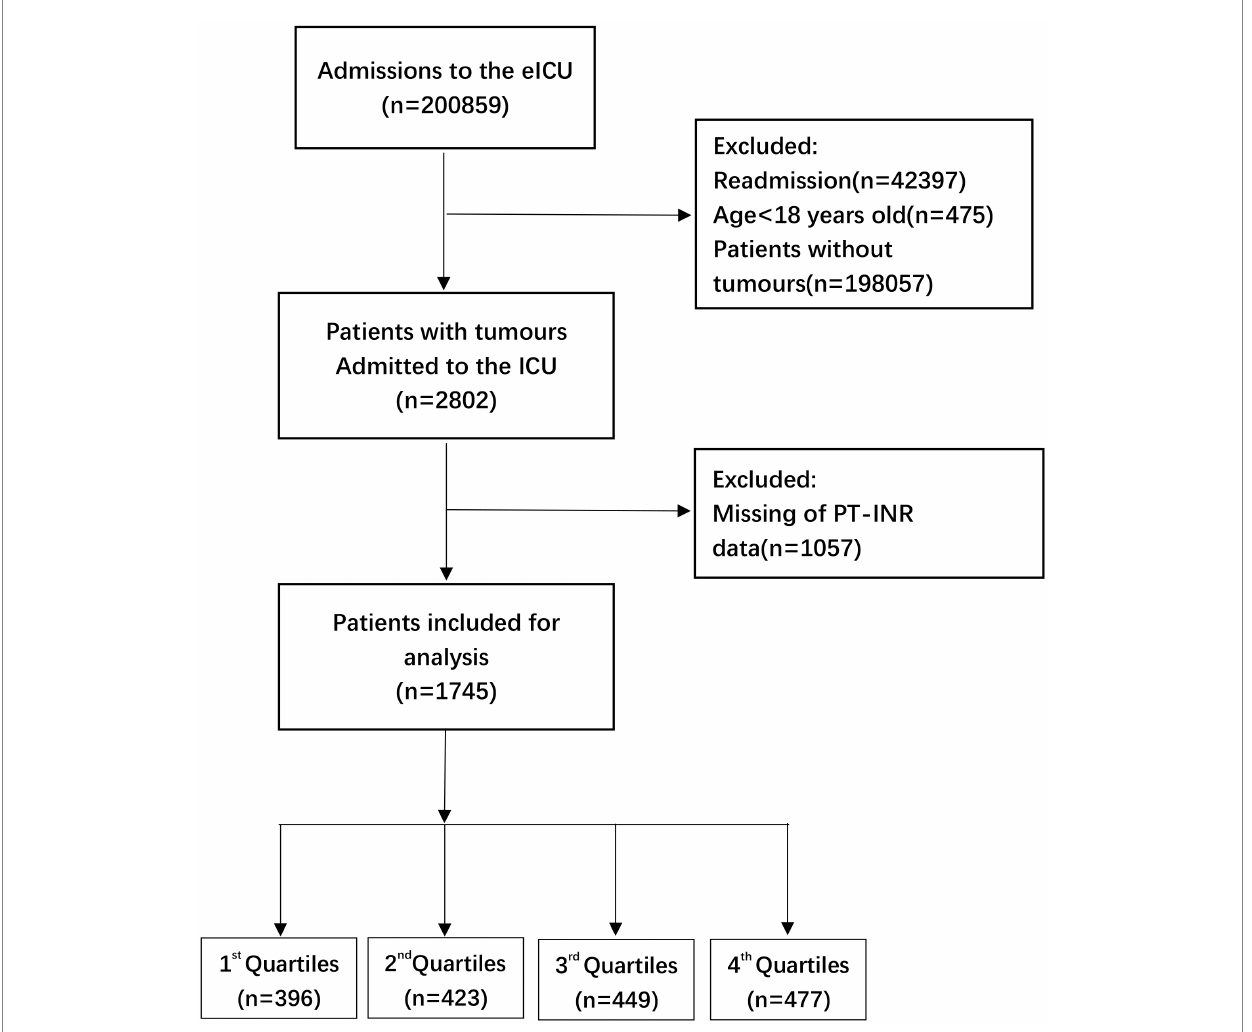
FIGURE 1 Flow chart of patient selection related to PT-INR. eICU, electronic intensive care unit; ICU, intensive carse